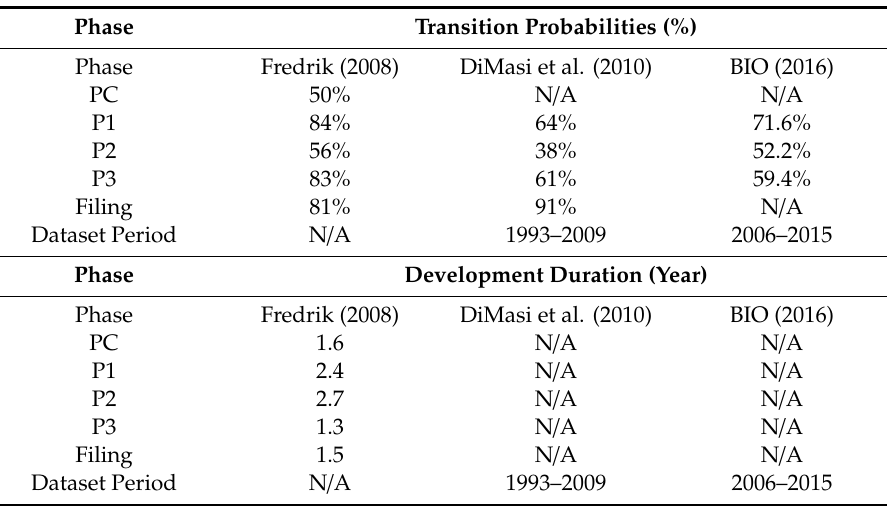
Table 6. Current state of previous studies and omitted